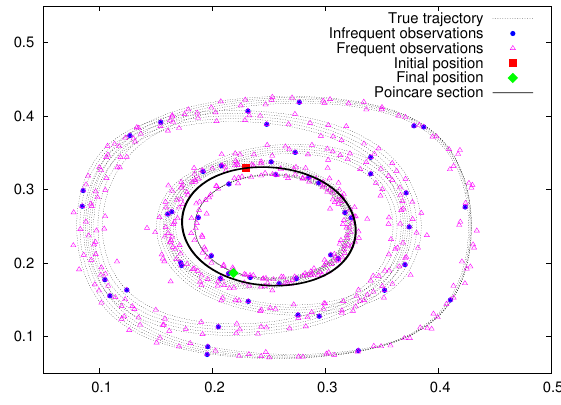
Fig. 3. The trajectory used to study the effect of shear on data assimilation